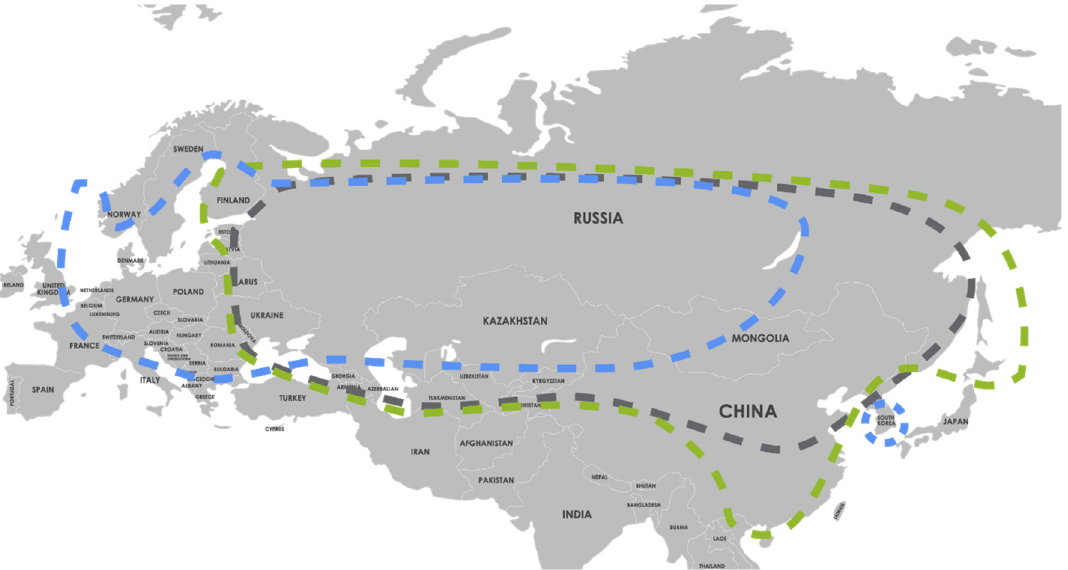
Figure 1. Distribution of tick-borne encephalitis virus (TBEV) subtypes in Europe and Asia. Dotted blue line, TBEV-EU: prevalent in Europe with virus isolates identified in Siberia and as far east as Lake Baikal. Dotted green line, TBEV-Sib: prevalent in Siberia and the Ural region with virus isolates identified as far west as the Baltics and Moldavia. Dotted gray line, TBEV-FE: prevalent in the far eastern region of Russia, with virus isolates identified as far west as the Baltics and Moldavia. Adapted and reprinted with permission from Ref. [10]. Copyright 2021 Global Health Press Pte Ltd.